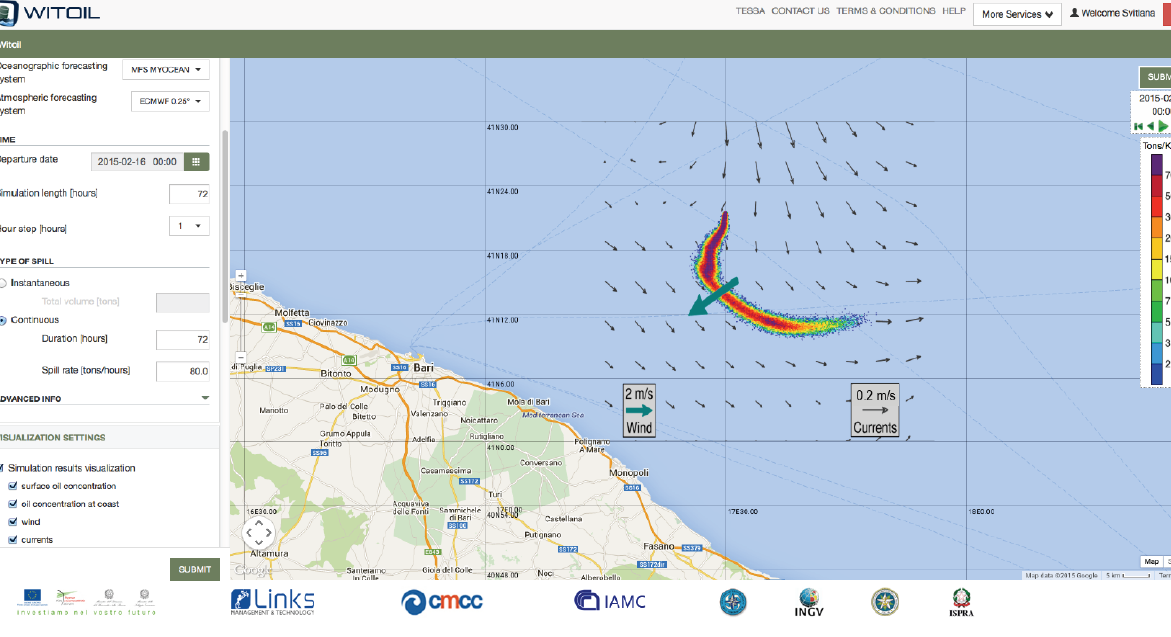
Figure 7. Result of the oil spill forecast in 72h after the accident.